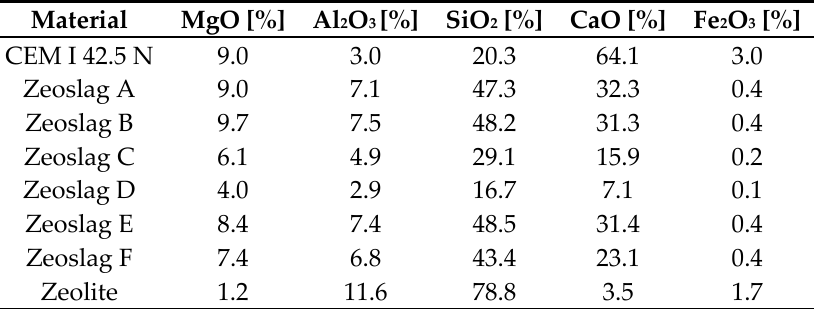
Table 1. Chemical composition of